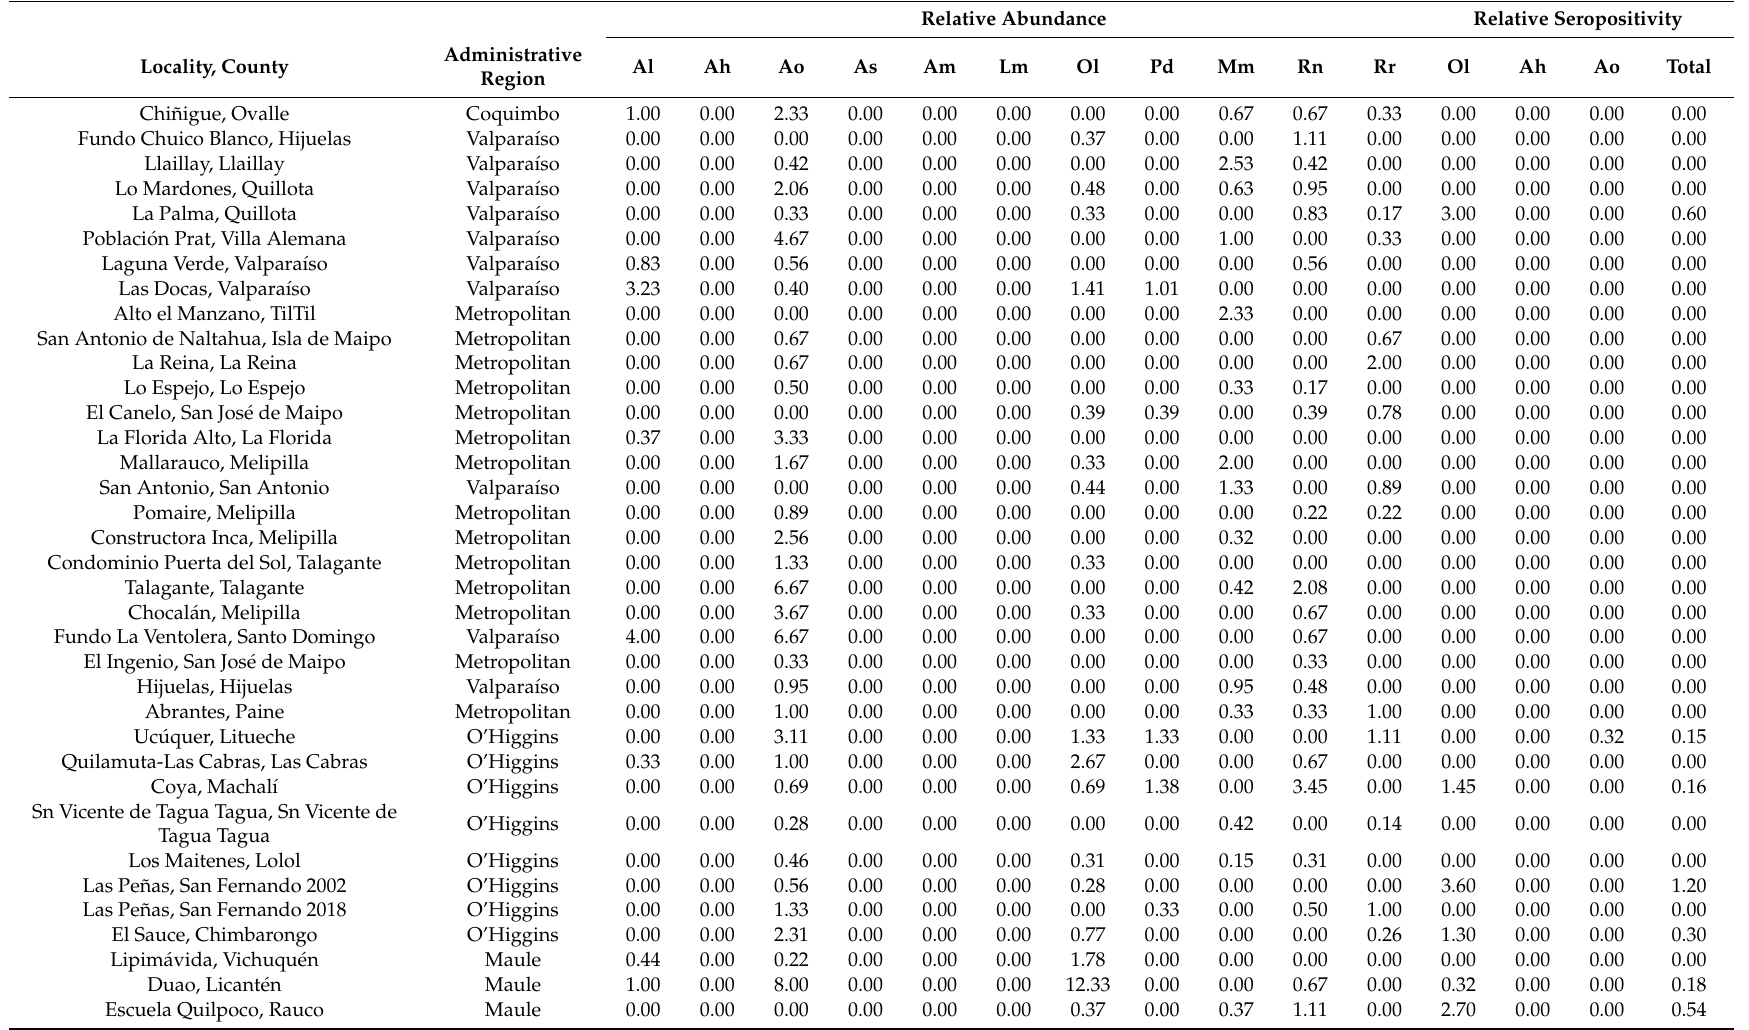
Table 1. Relative abundance and relative seropositivity to ANDV by locality and